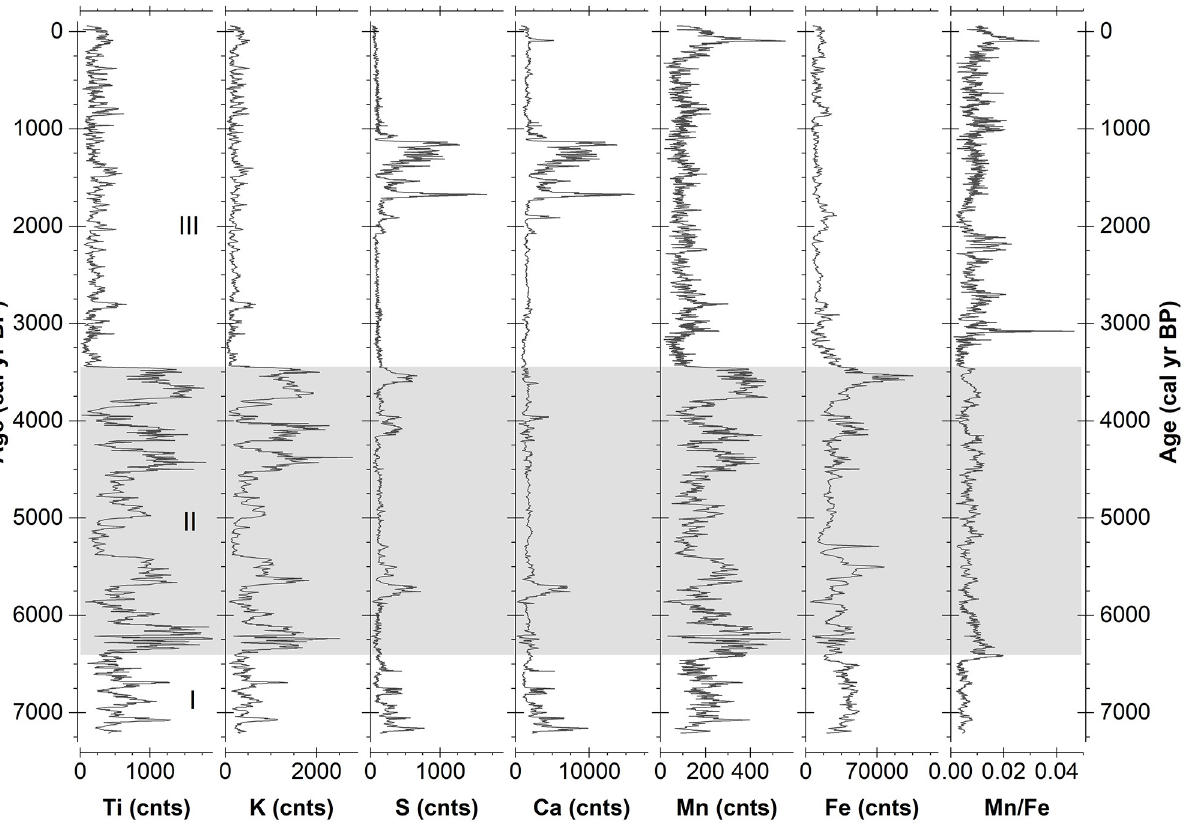
Fig 3. Minerogenic components of the CTP composite profile. Shown are titanium (Ti), potassium (K), sulphur (S), calcium (CA), manganese (Mn), iron (Fe) and the Mn to Fe ratio (Mn/Fe). The grey bar indicates the period with considerable fluctuations of clastic elements.